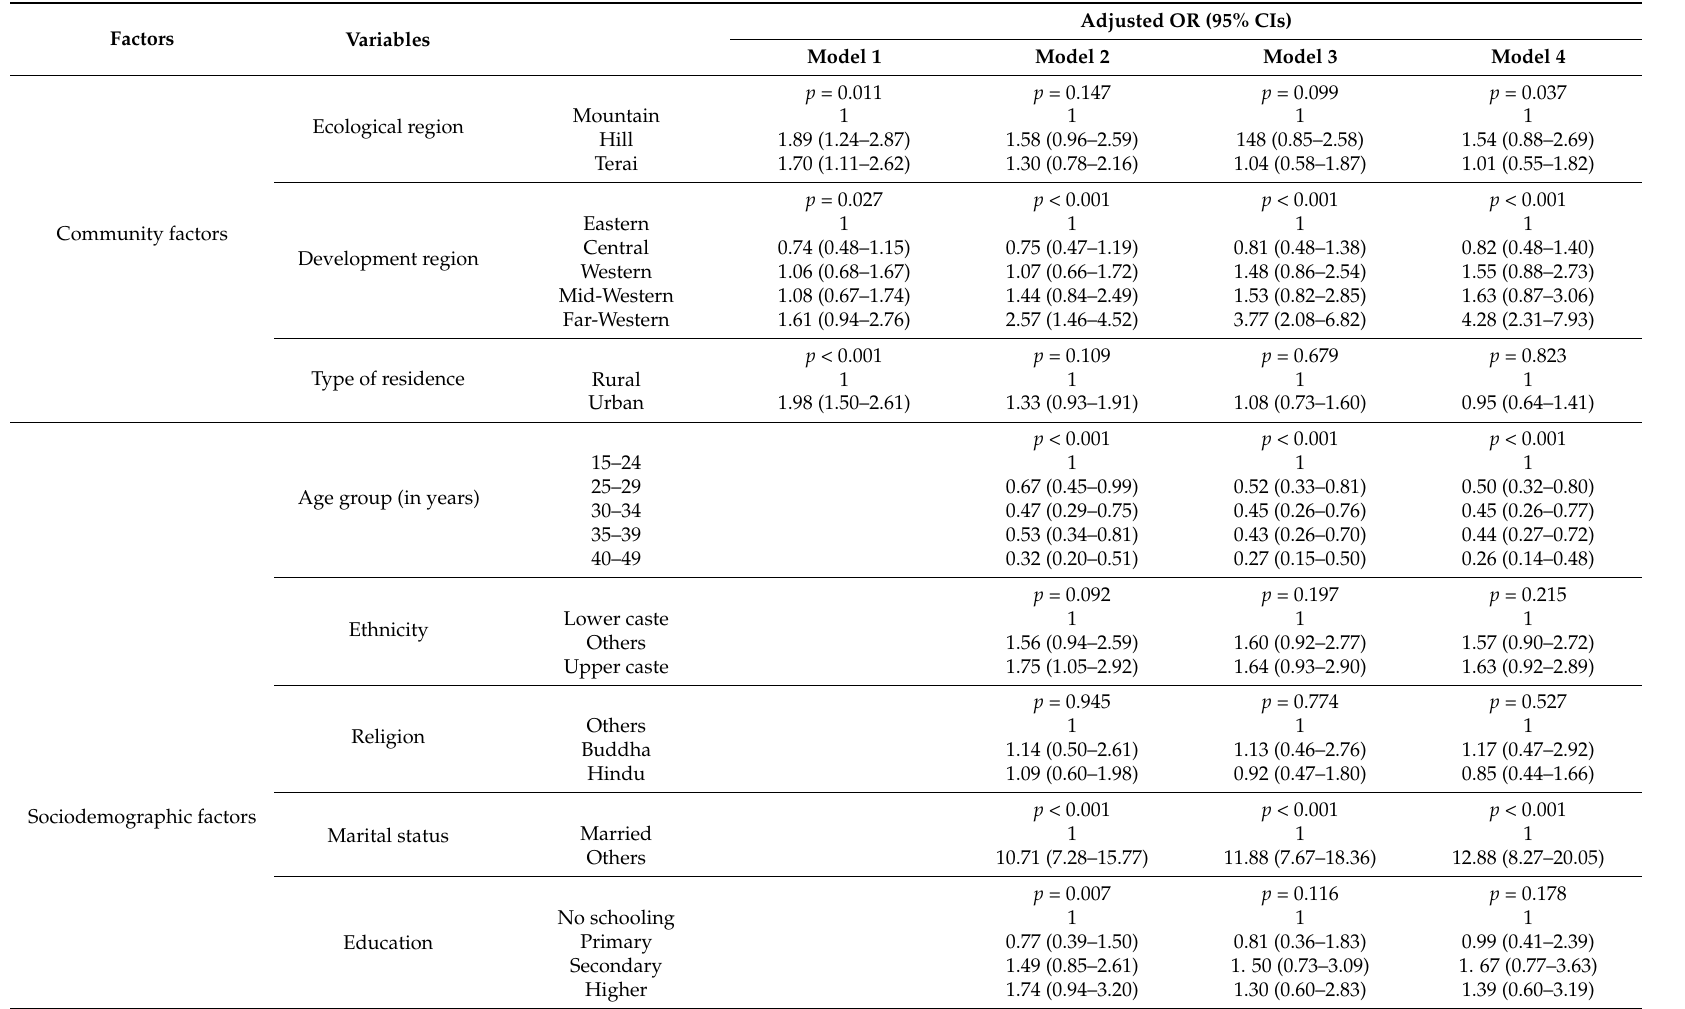
Table 3. Logistic Regression Analysis of Factors Associated with Condom Use among